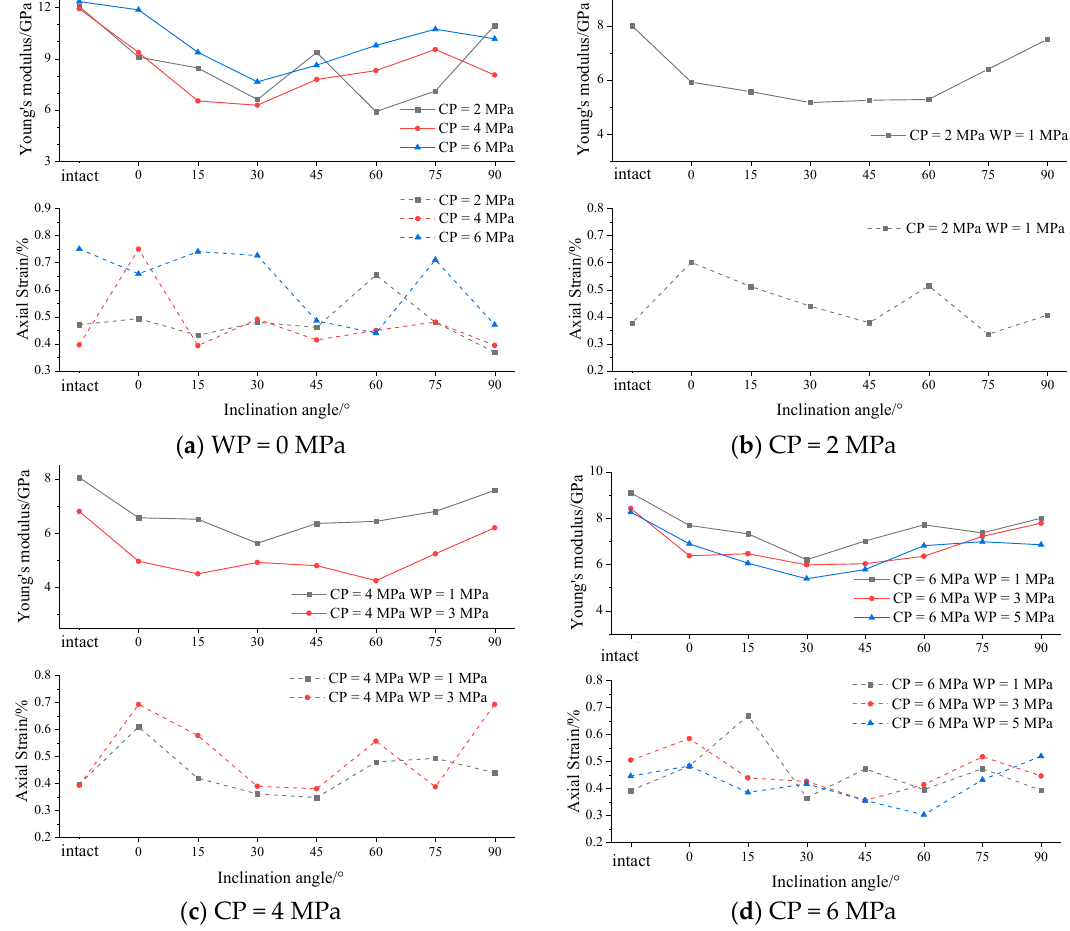
Figure 8. Results of Young’s modulus and the peak axial strain. ( a ) Uniaxial compression test and conventional triaxial compression test; ( b ), ( c ) and ( d ) hydraulic coupled triaxial test under 2 MPa, 4 MPa, and 6 MPa confining pressure, respectively.